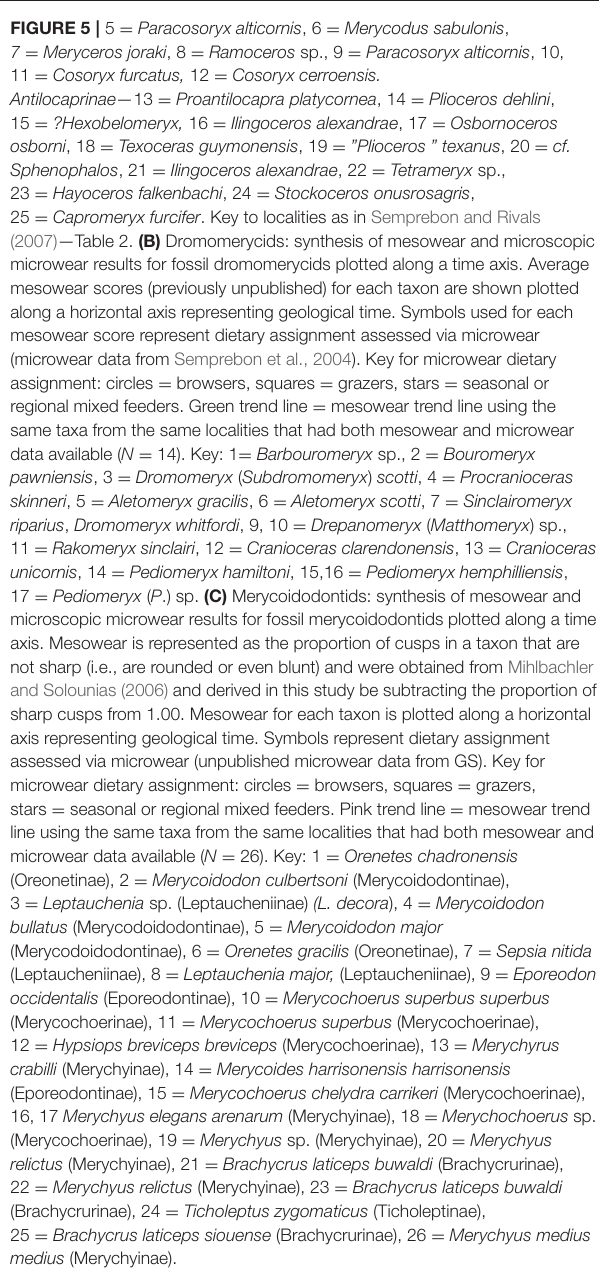
FIGURE 5 | 5 = Paracosoryx alticornis , 6 = Merycodus sabulonis , 7 = Meryceros joraki , 8 = Ramoceros sp., 9 = Paracosoryx alticornis , 10, 11 = Cosoryx furcatus, 12 = Cosoryx cerroensis. Antilocaprinae— 13 = Proantilocapra platycornea , 14 = Plioceros dehlini , 15 = ?Hexobelomeryx, 16 = Ilingoceros alexandrae , 17 = Osbornoceros osborni , 18 = Texoceras guymonensis , 19 = ”Plioceros ” texanus , 20 = cf. Sphenophalos , 21 = Ilingoceros alexandrae , 22 = Tetrameryx sp., 23 = Hayoceros falkenbachi , 24 = Stockoceros onusrosagris , 25 = Capromeryx furcifer . Key to localities as in Semprebon and Rivals (2007)—Table 2. (B) Dromomerycids: synthesis of mesowear and microscopic microwear results for fossil dromomerycids plotted along a time axis. Average mesowear scores (previously unpublished) for each taxon are shown plotted along a horizontal axis representing geological time. Symbols used for each mesowear score represent dietary assignment assessed via microwear (microwear data from Semprebon et al., 2004). Key for microwear dietary assignment: circles = browsers, squares = grazers, stars = seasonal or regional mixed feeders. Green trend line = mesowear trend line using the same taxa from the same localities that had both mesowear and microwear data available ( N = 14). Key: 1 = Barbouromeryx sp., 2 = Bouromeryx pawniensis , 3 = Dromomeryx ( Subdromomeryx ) scotti , 4 = Procranioceras skinneri , 5 = Aletomeryx gracilis , 6 = Aletomeryx scotti , 7 = Sinclairomeryx riparius , Dromomeryx whitfordi , 9, 10 = Drepanomeryx ( Matthomeryx ) sp., 11 = Rakomeryx sinclairi , 12 = Cranioceras clarendonensis , 13 = Cranioceras unicornis , 14 = Pediomeryx hamiltoni , 15,16 = Pediomeryx hemphilliensis , 17 = Pediomeryx ( P .) sp. (C) Merycoidodontids: synthesis of mesowear and microscopic microwear results for fossil merycoidodontids plotted along a time axis. Mesowear is represented as the proportion of cusps in a taxon that are not sharp (i.e., are rounded or even blunt) and were obtained from Mihlbachler and Solounias (2006) and derived in this study be subtracting the proportion of sharp cusps from 1.00. Mesowear for each taxon is plotted along a horizontal axis representing geological time. Symbols represent dietary assignment assessed via microwear (unpublished microwear data from GS). Key for microwear dietary assignment: circles = browsers, squares = grazers, stars = seasonal or regional mixed feeders. Pink trend line = mesowear trend line using the same taxa from the same localities that had both mesowear and microwear data available ( N = 26). Key: 1 = Orenetes chadronensis (Oreonetinae), 2 = Merycoidodon culbertsoni (Merycoidodontinae), 3 = Leptauchenia sp. (Leptaucheniinae) (L. decora ), 4 = Merycoidodon bullatus (Merycodoidodontinae), 5 = Merycoidodon major (Merycodoidodontinae), 6 = Orenetes gracilis (Oreonetinae), 7 = Sepsia nitida (Leptaucheniinae), 8 = Leptauchenia major, (Leptaucheniinae), 9 = Eporeodon occidentalis (Eporeodontinae), 10 = Merycochoerus superbus superbus